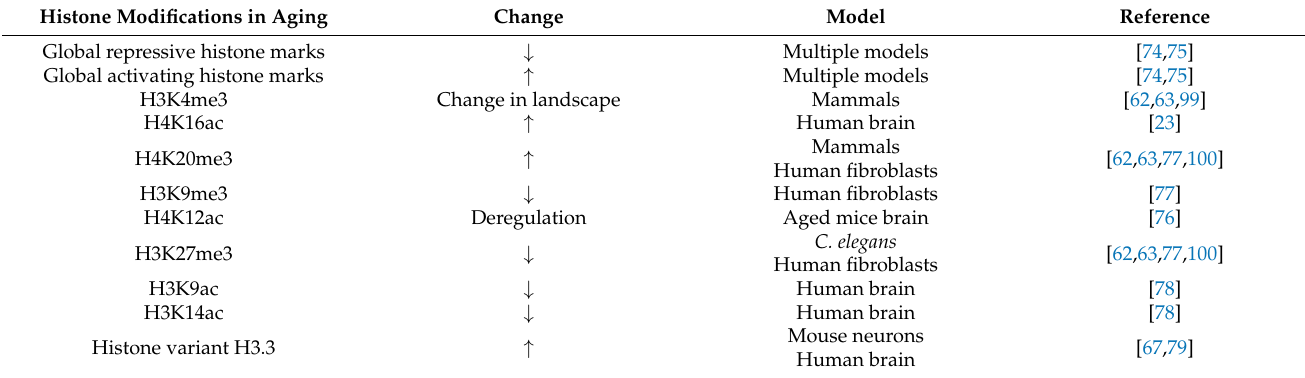
Table 1. Main histone modification changes associated with aging and